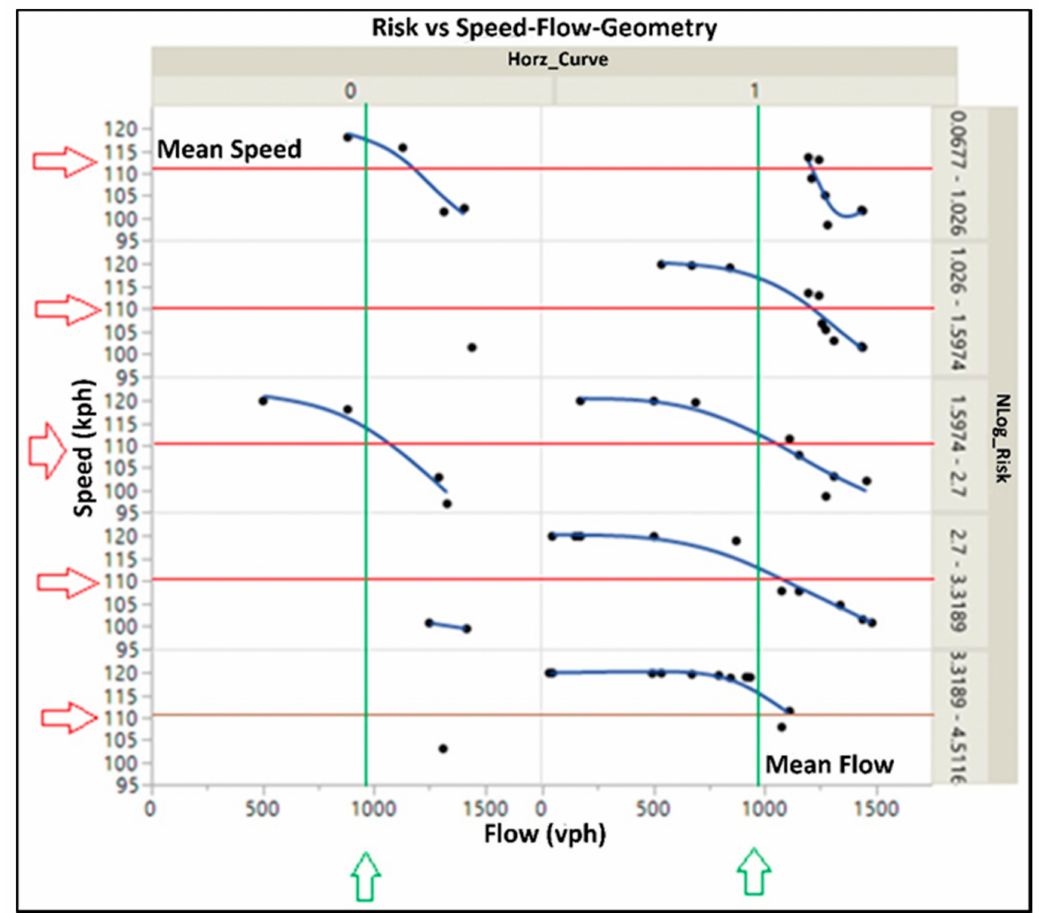
Figure 7. Contributing Factor based Risk